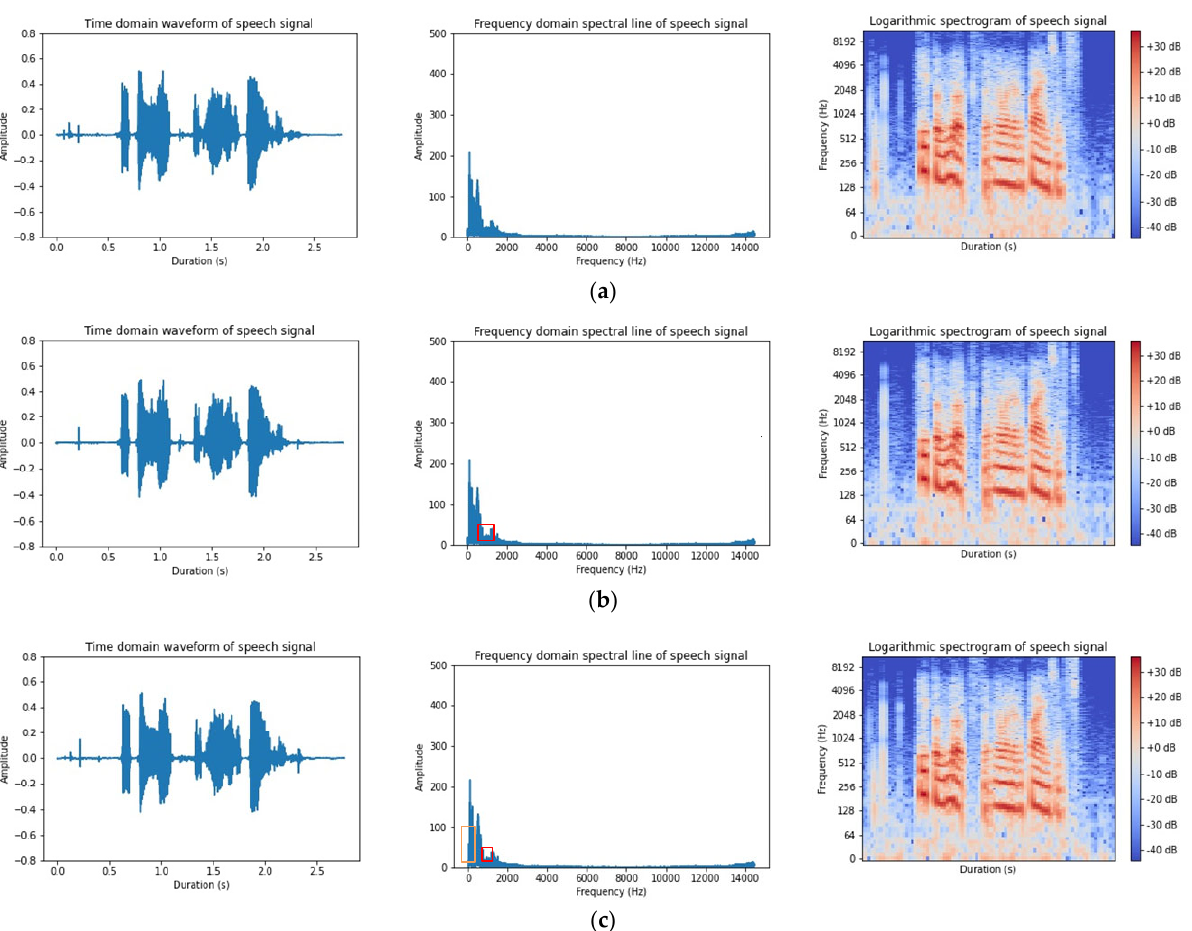
Figure 8. Comparison of speech enhancement samples: ( a ) flash MANNER; ( b ) flash fuse MANNER; and ( c ) AF ‐ MANNER.